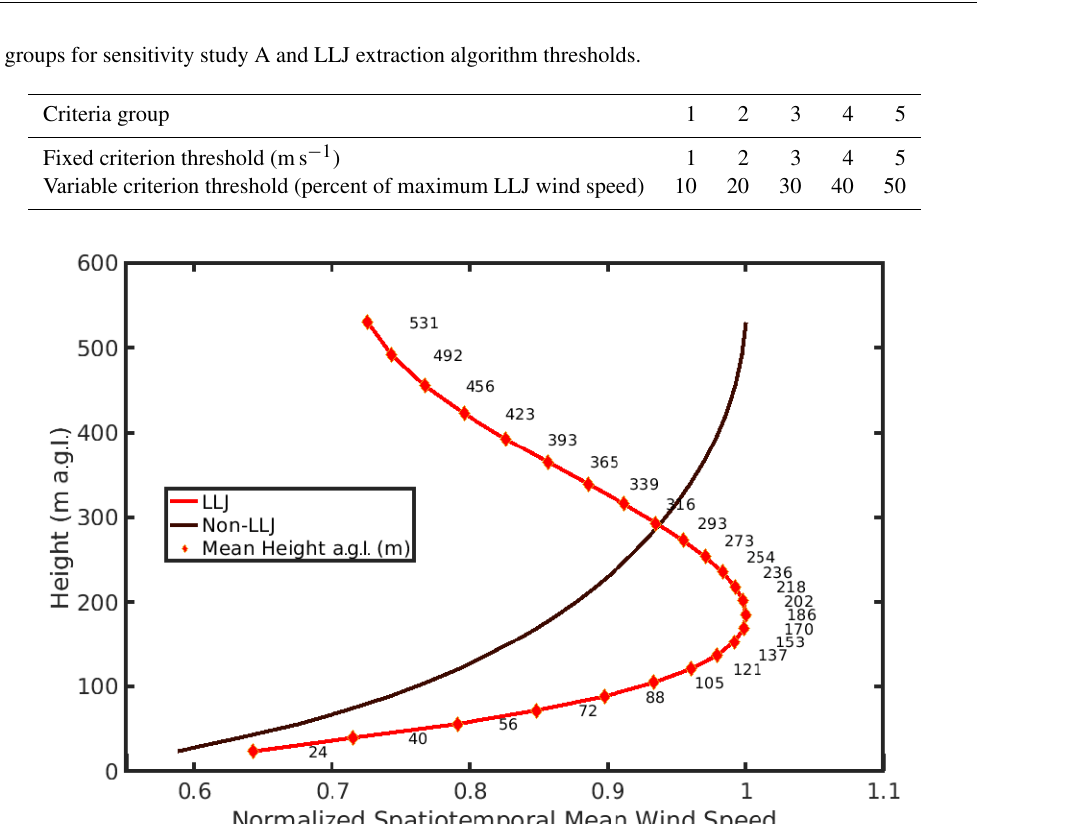
Figure 3. Mean wind speed profiles during all hours identified as exhibiting LLJs and those without (non-LLJ). These profiles are computed from all hourly profiles (in the entire time domain from December 2007 to May 2008) from all grid cells, and each profile is normalized by the maximum wind speed after compositing. The LLJ detection algorithm uses a variable threshold of 20%. Both mean wind speed profiles are plotted against the temporally and spatially averaged mean height of each vertical